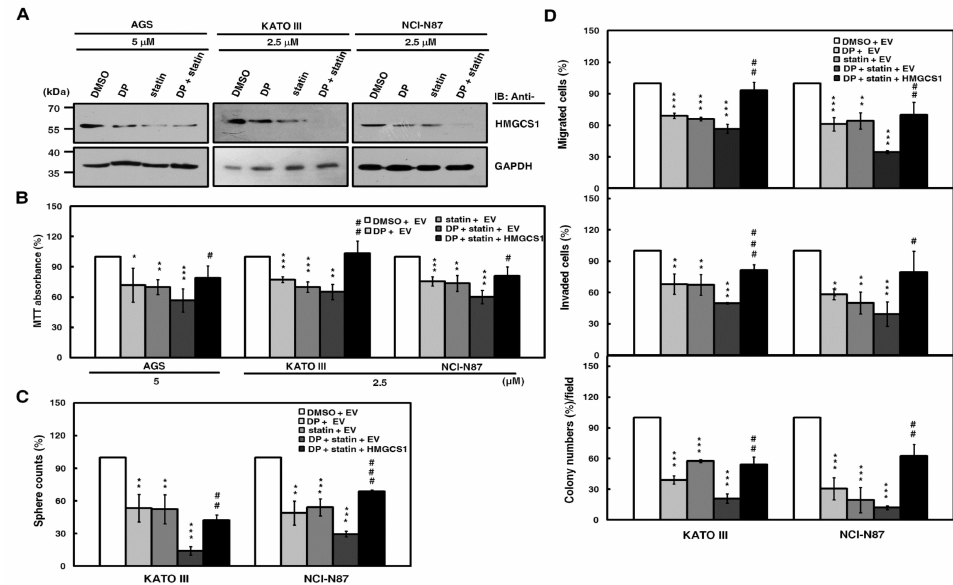
Figure 5. Suppression of growth and progression in gastric cancer cells by the blockade of the mevalonate pathway is partially reversed by HMGCS1 overexpression. ( A ) For the blockade of the mevalonate pathway, AGS, KATO III, and NCI-N87 cells were treated with 2.5 or 5 µ M lovastatin (statin) and / or dipyridamole (DP) for 24 h. Then, whole-cell extracts of the treated cells were prepared for Western blot analyses using anti-HMGCS1 and anti-GAPDH antibodies. ( B – D ) AGS, KATO III, and NCI-N87 cells were transfected with the HMGCS1-expressing construct (HMGCS1) or empty vector (EV) for 48 h. Then, the transfected cells were treated with lovastatin and / or dipyridamole for 24 h for the subsequent MTT assay ( B ). The transfected KATO III and NCI-N87 cells were also seeded for assays of tumorsphere formation ( C ), migration, invasion, and colony formation ( D ) in the presence or absence of 2.5 µ M of lovastatin and / or dipyridamole. Mean ± SD ( n = 3). *, p < 0.05; **, p < 0.01; ***, p < 0.001. #, p < 0.05; ##, p < 0.01; ###, p <